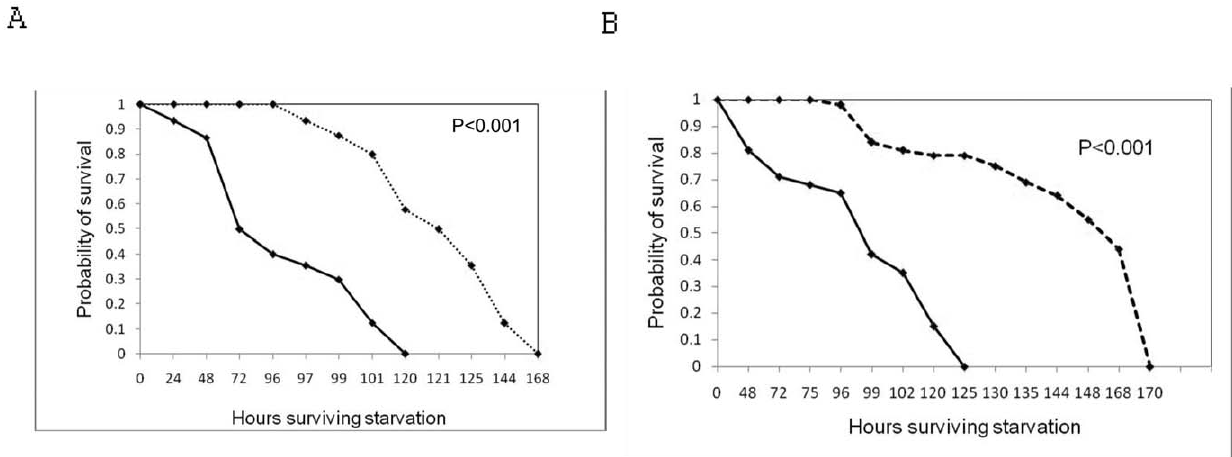
Figure 2. Survival curves for starvation resistance in males (A) and females (B) derived from either protein (–) or carbohydrate (- - -) enriched medium.